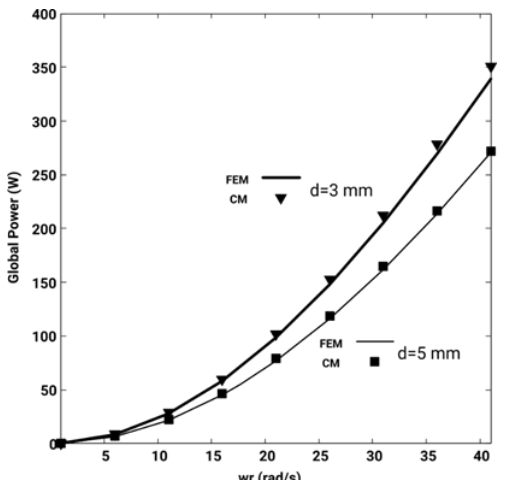
Figure 9. Comparison of the global heat power in the disk as a function of w r , for d = 3 and 5 mm, using the CM and the FEM. Both simulations are practically coincident.